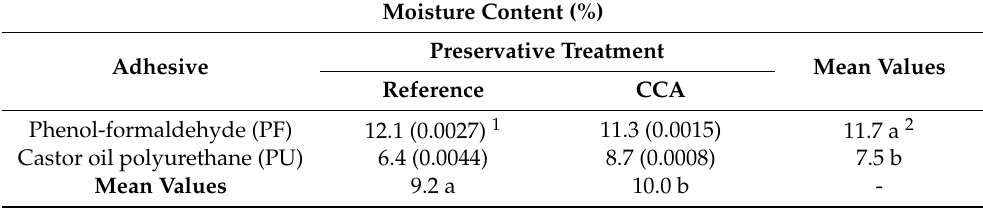
Table 4. Results: moisture